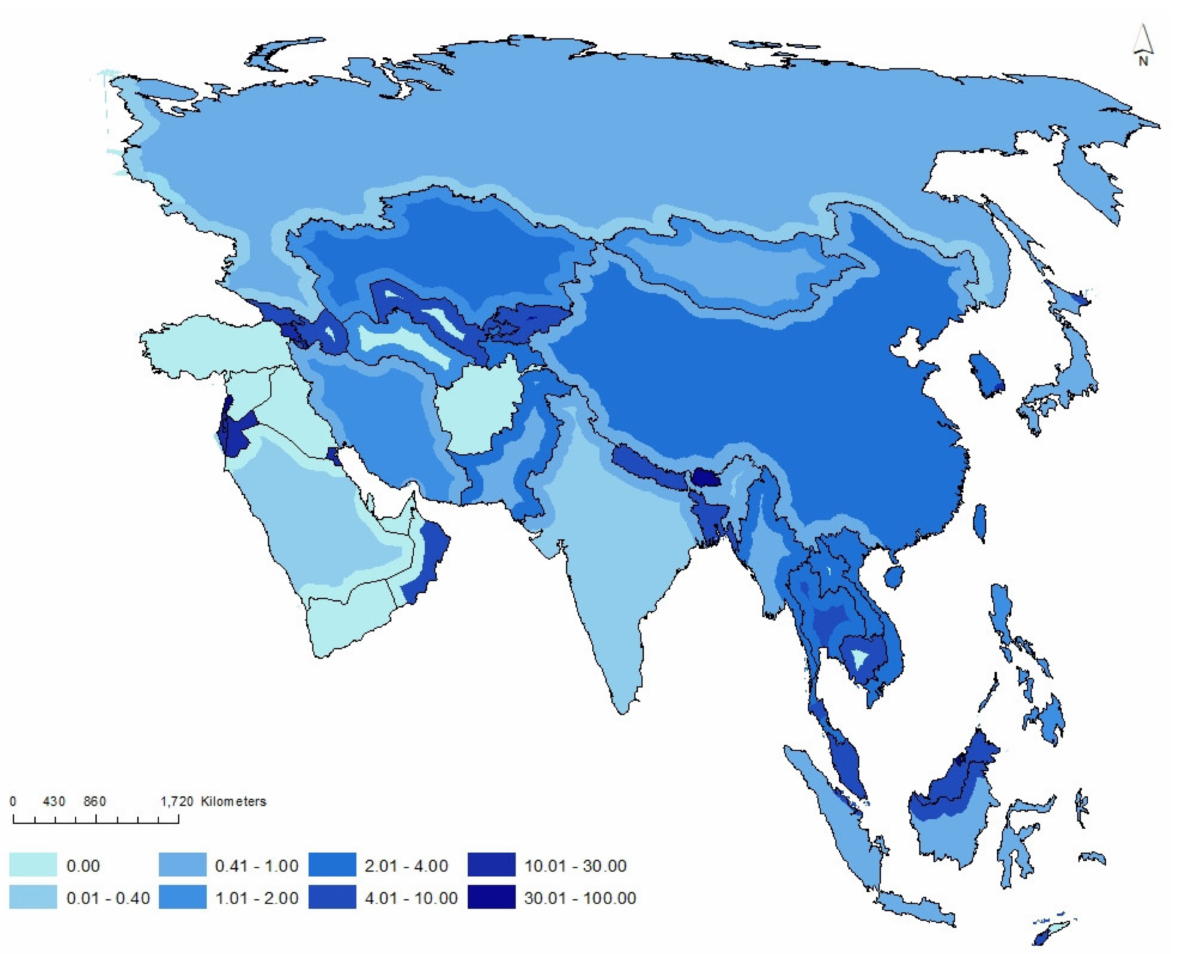
Figure 6. Protected areas connectivity at country level, using the CONNECT metric at 20 km threshold, in border and inner area of each country in the study